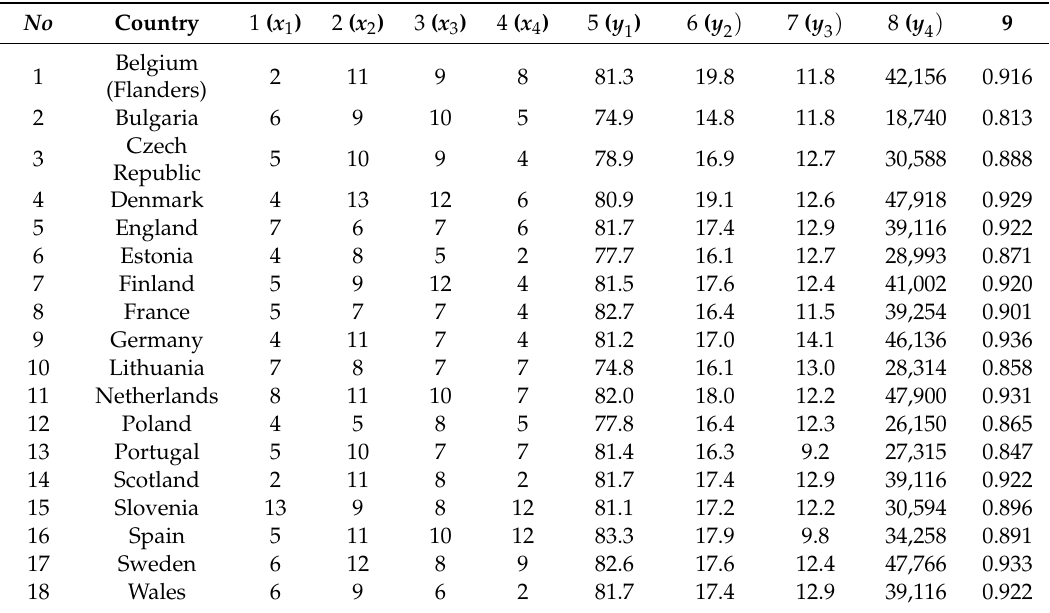
Table 1. Global Matrix 3.0 and human development indices and indicators, 2018 statistical